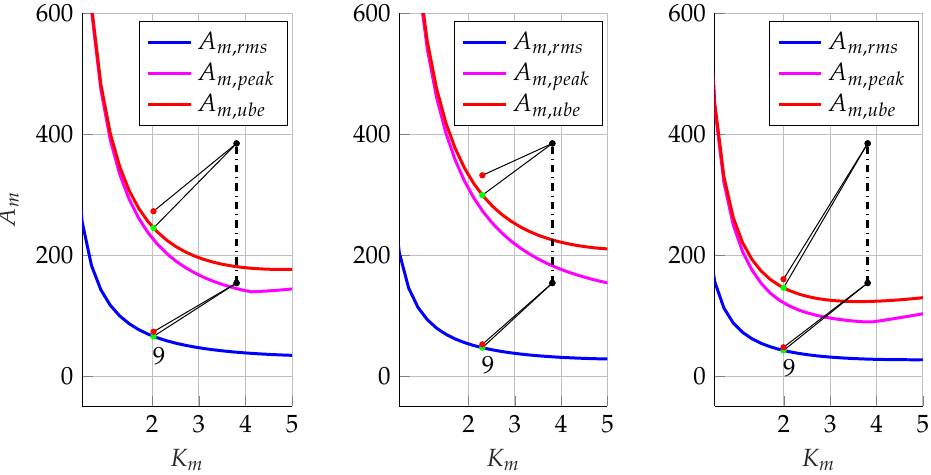
Figure 18. Feasible reduction ratios (7, 9 and 12) for the power drive system 4 applied to axes 1 ( left ), 2 ( middle ) and 3 ( right ), considering mixed-load condition.